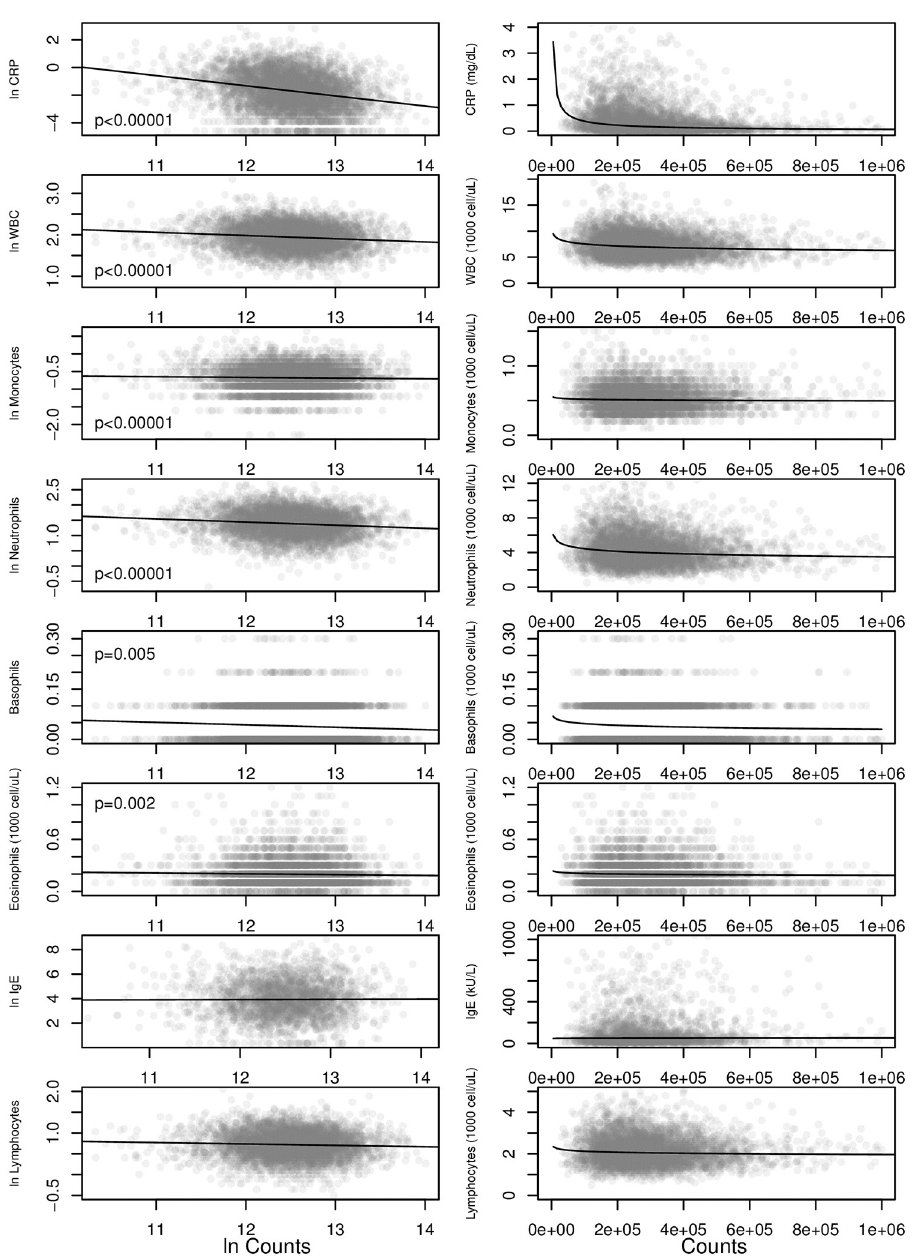
Fig 3. Physical activity and immune functions. Immune and inflammatory markers decrease as total counts increase. Left column shows ln-transformed marker values (except basophils and eosinophils) versus ln-transformed counts. Right column: untransformed values. P-values are for ln(counts) in general linear models with BMI, age, and gender as covariates. P-values for ln(IgE) and ln(lymphocytes) did not achieve the Bonferoni corrected significance criterion p = 0.005. Trend lines in both columns are the ordinary least squares regressions for ln-transformed